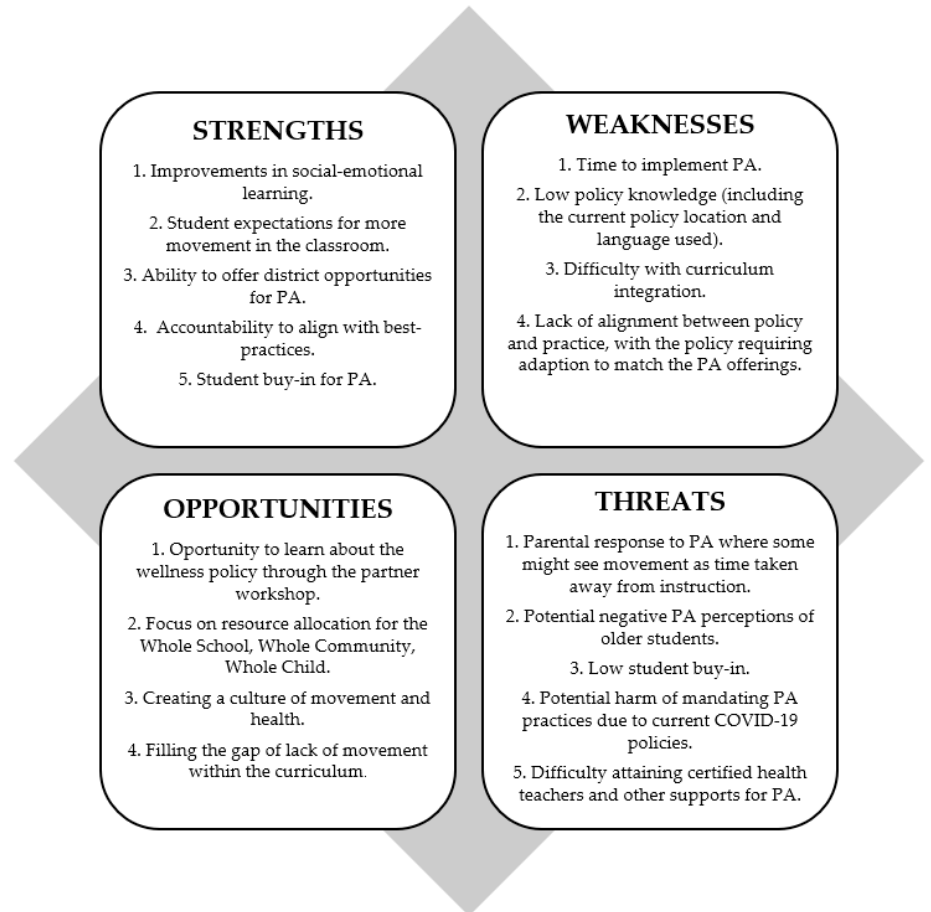
Figure 2. Strengths, weaknesses, opportunities, and threats identified by the school district leaders related to tailored policy implementation, [22].